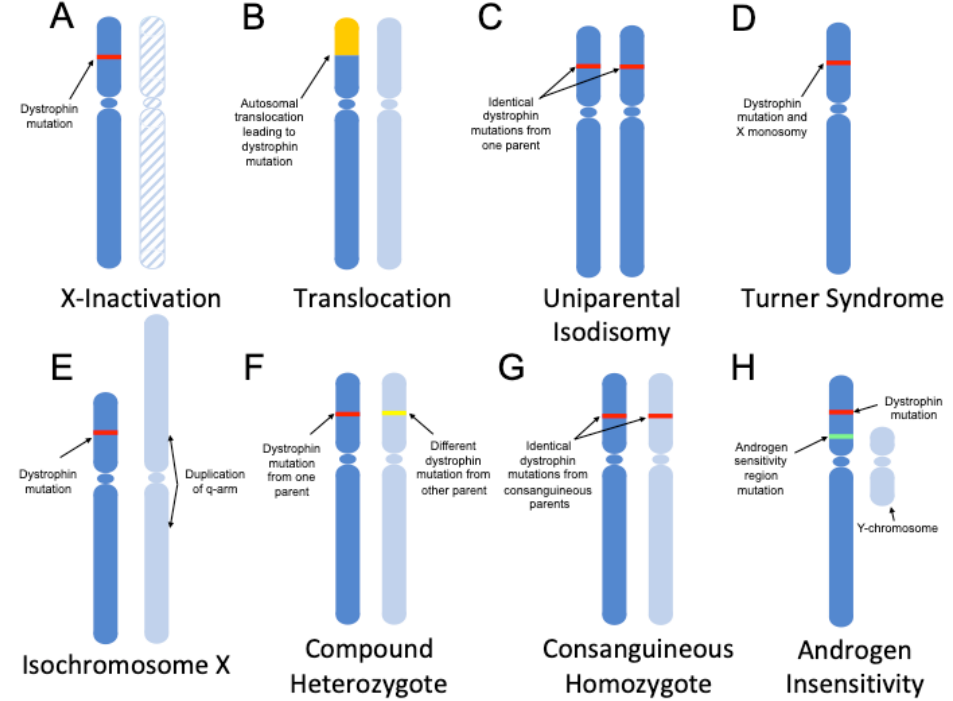
Figure 1. Genetic mechanisms of dystrophinopathy manifestation in females. Chromosomes from different parents are represented by different shades of blue, with the DMD mutation represented by a red or yellow line. Females with dystrophin mutations may manifest symptoms as a result of: ( A ) skewed X chromosome inactivation (the inactive chromosome is hashed); ( B ) balanced translocations with an autosome, represented in yellow, involving regions within the DMD gene; ( C ) uniparental isodisomy; ( D ) inheritance of a single DMD mutation-containing X-chromosome (a subcategory of Turner syndrome); ( E ) Xq isochromosome formation in tandem with a DMD mutation on the other X chromosome; ( F ) compound heterozygosity, with the inheritance of two different DMD mutations on either chromosome; ( G ) homozygous DMD mutation inheritance due to consanguinity; and ( H ) androgen insensitivity in an X/Y female (due to an androgen receptor mutation, represented by a green line) in tandem with a DMD mutation.